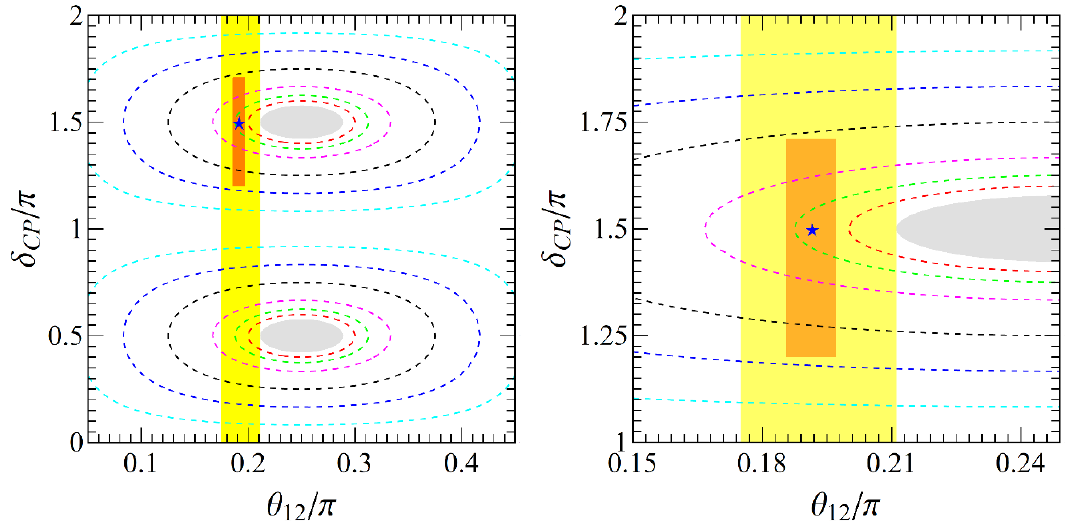
Figure 2 . Correlation between (cid:14) CP and (cid:18) 12 for various (cid:2) values, where (cid:2) labels the residual CP symmetry. Cyan, blue, black, pink, green and red dashed lines correspond to (cid:25)= 12, (cid:25)= 6, (cid:25)= 4, (cid:25)= 3, 3 (cid:25)= 8 and 2 (cid:25)= 5 respectively. The orange and yellow bands indicate the allowed 1 (cid:27) and 3 (cid:27) regions (NO case), respectively. The best (cid:12)t point of (cid:18) 12 and (cid:14) CP is indicated with a star. The gray region corresponding to 0 (cid:20) j cos (cid:2) j (cid:20) 0 : 242 is excluded at the 3 (cid:27) level